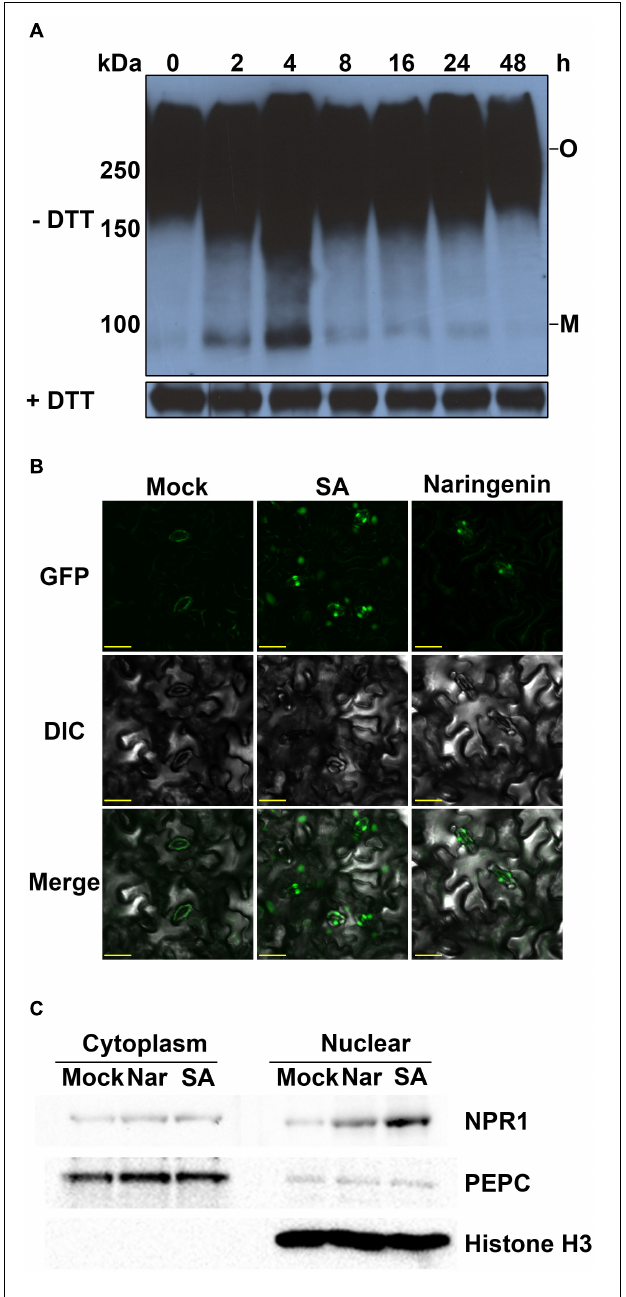
FIGURE 2 | Naringenin induces the monomerization and nuclear translocation of NPR1. (A) The monomerization of NPR1 by naringenin. 35S::NPR1-GFP transgenic plants (in npr1-2 ) were treated with 100 µ M naringenin. Plants were collected at the indicated time points after naringenin treatment. Total protein (30 µ g) was extracted and subjected to SDS-PAGE with or without DTT in the sample buffer (62.5 mM Tris-HCl pH 6.8, 10% glycerol, 1% lithium dodecyl sulfate (LDS), and 0.005% Bromophenol Blue) and analyzed using immunoblot using polyclonal anti-NPR1 antibodies. Both oligomeric (O) and monomeric (M) forms of NPR1 were detected. (B) Subcellular localization of NPR1-GFP by naringenin. Confocal microscope images of NPR1-GFP fluorescence in representative guard cells. Leaf tissues from the 35S::NPR1-GFP treated with or without 100 µ M naringenin for 3 h